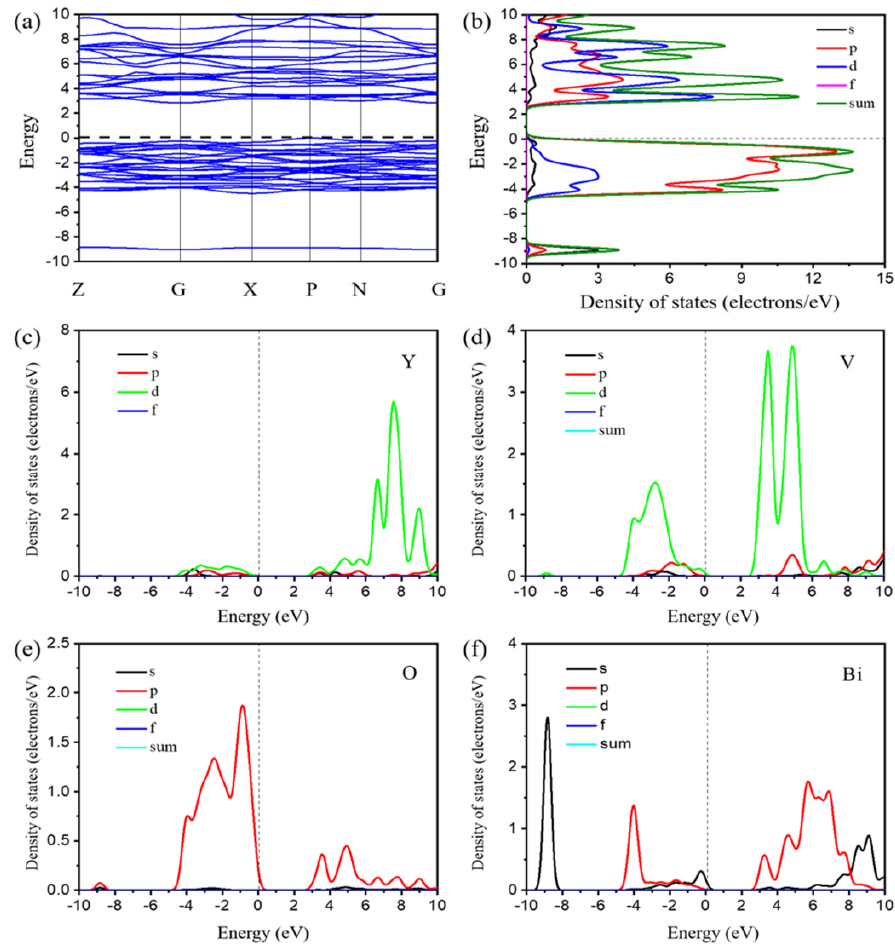
Figure 4. The calculated energy band structure and density of states of YVO 4 :Bi,Eu ( a , b ). Partial densities of states of YVO 4 :Bi,Eu ( c – f ) near the Fermi energy level (the Fermi energy is the zero of the energy scale).